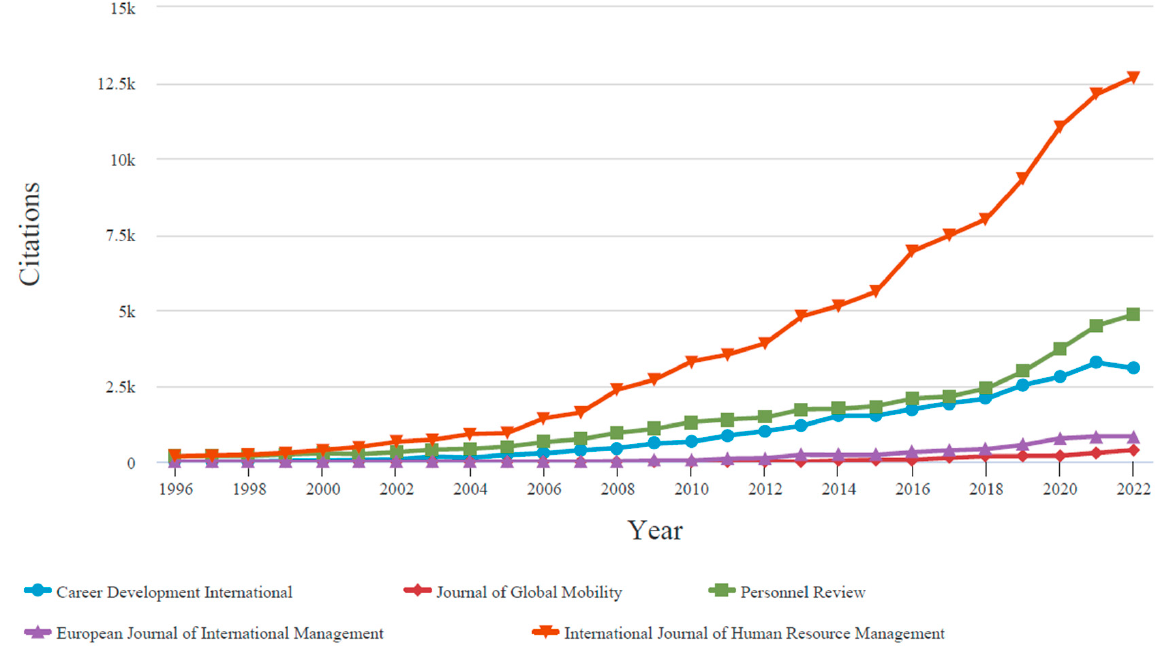
Figure 9. Source citations by year (excluding self-citations). Source: Data obtained from Scopus (August 2022).